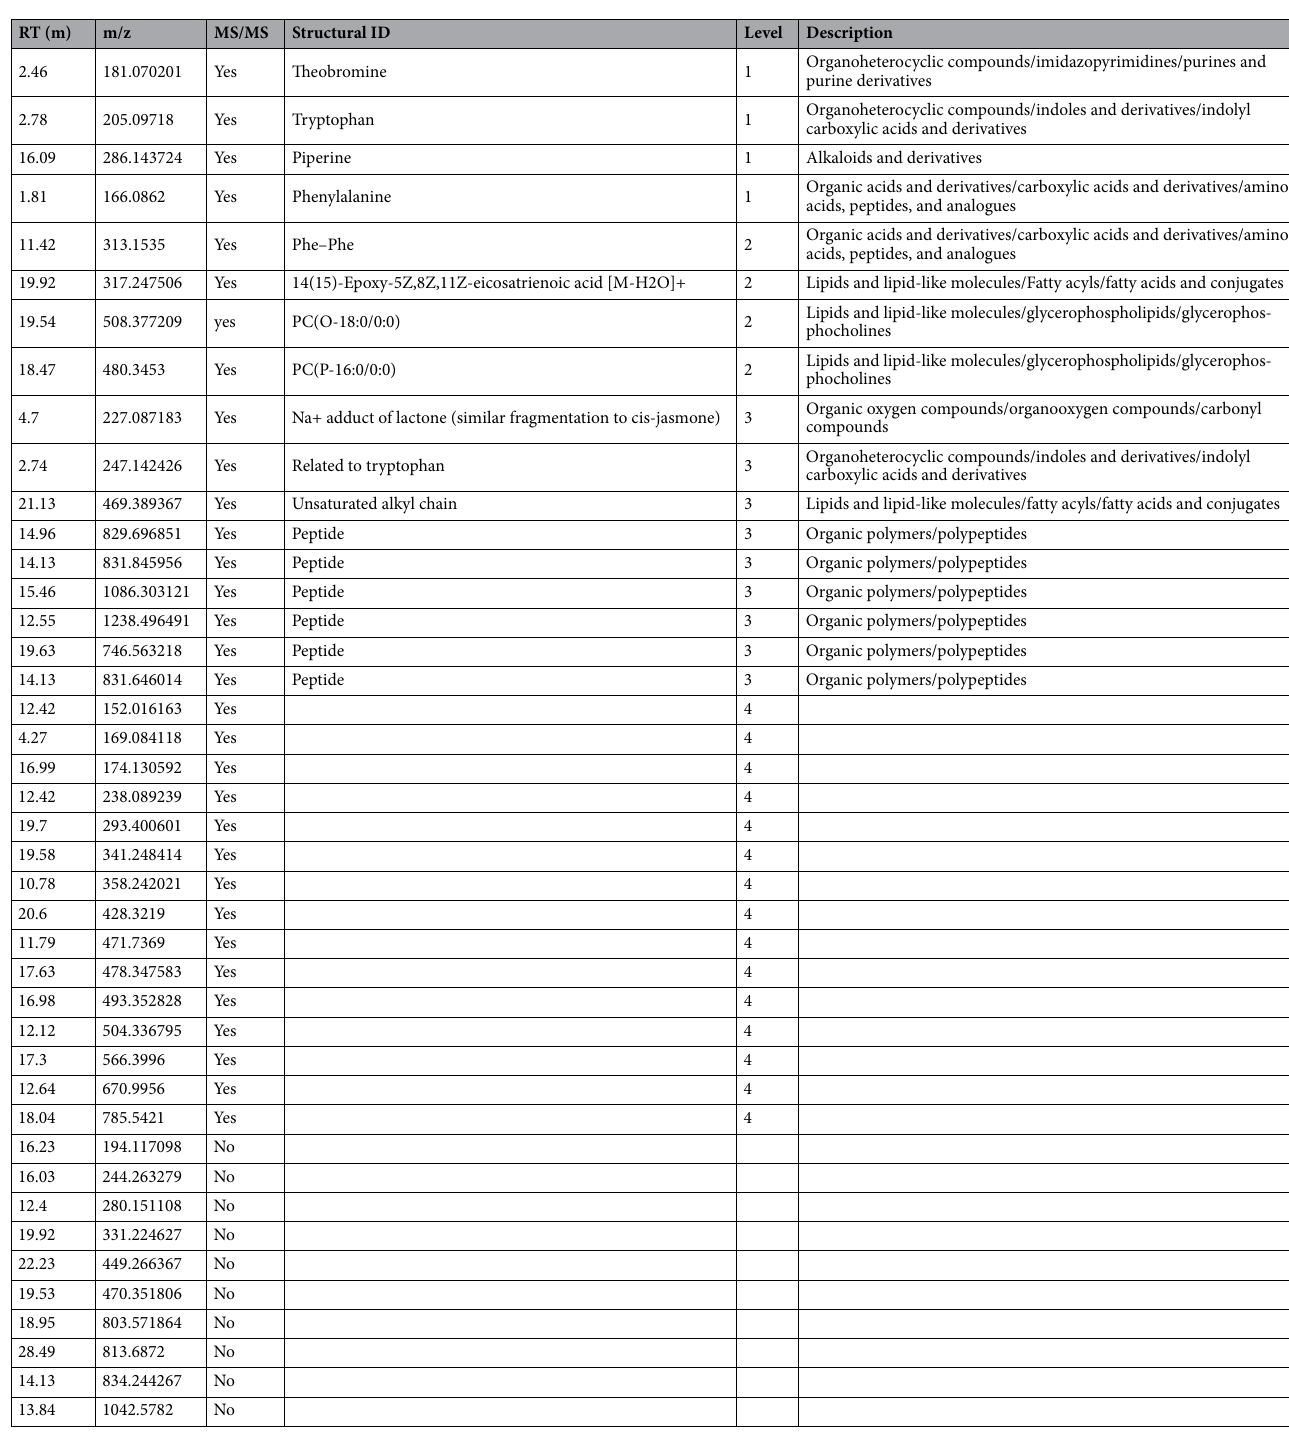
Table 5. MSMS results of selected biomarkers selected by k FFS. The RT column indicates the retention time in minutes. The M/Z column indicates the mass divided by charge of the